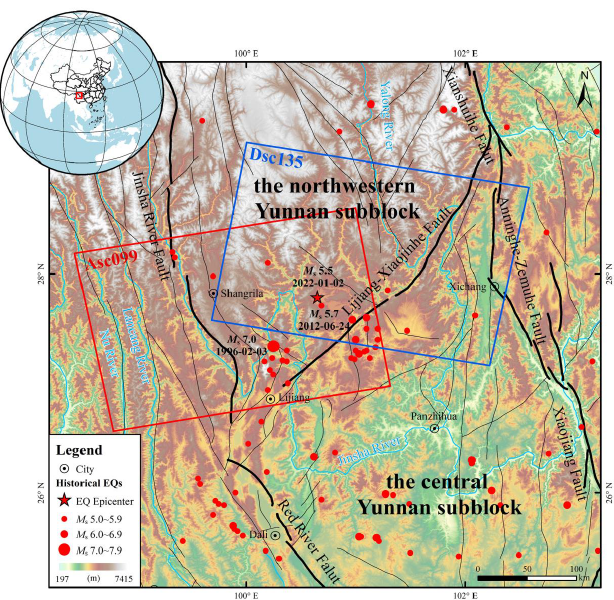
Figure 1. The historical earthquake distribution map of the northwestern Yunnan subblock to the central Yunnan subblock and neighboring areas. The faults are based on the “ Active Tectonic Map of China (1:4 million) ” [57]. Historical earthquakes are from CENC ’ s catalogue of earthquakes greater than 5.0 magnitude from 1970 to the present. The base map is NASADEM from Earthdata [58]. 2. Geological and Tectonic Background The Ninglang area of Lijiang, China, is located in the middle of the Sichuan – Yunnan rhombic block, in the southwest section of the Lijiang – Xiaojinhe Fault. Due to the collision and subduction of the Indo-Eurasian plate, a large amount of material from the southeast- ern margin of the Tibetan Plateau escaped in the southeastern direction, and the Sichuan – Yunnan region rotated clockwise around the Himalayan East tectonic knot, forming the current tectonic pattern of the Sichuan – Yunnan rhombic block [2,59 – 62]. The complex in- terlocking geological formations, strong crustal deformation, and fracture activities cause moderate to strong earthquakes to occur frequently in the Ninglang area of Lijiang, and this area is known as the “ earthquake nest ” [63,64]. According to the historical earthquake catalog of the CENC (from 1970 to present), the southwest section of the Lijiang – Xiaojinhe Fault (Lijiang – Ninglang section) is more seismically active than the northeast section, with 23 earthquakes of M s 5.0 to 5.9, four earthquakes of M s 6.0 to 6.9, and one earthquake of